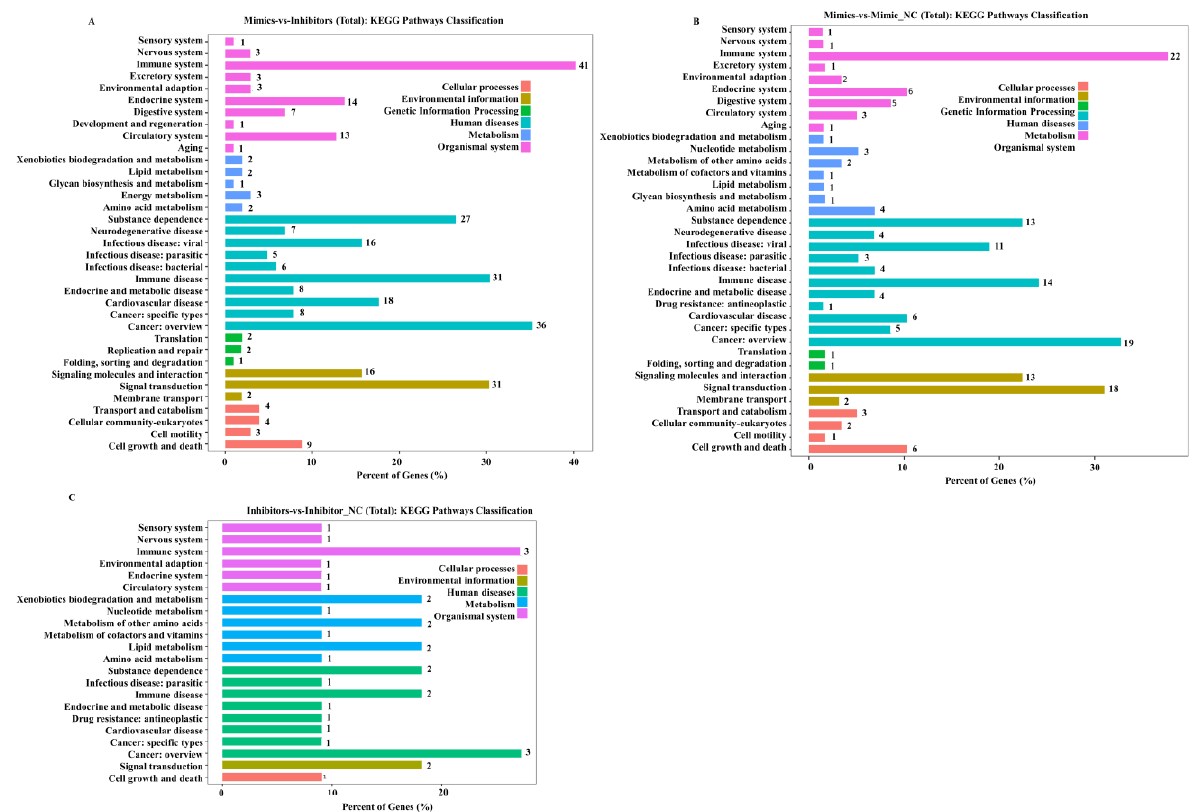
Figure 5. KEGG enrichment analyses of differentially expressed genes (DEGs) identified by RNA-seq in mouse NIH3T3 cells transfected with tRF-Trp-CCA-014 ( p < 0.05). ( A – C ) KEGG signalling pathways of Mimics vs. Inhibitors groups, Mimics vs. Mimic NC groups, and Inhibitors vs. Inhibitor NC groups, respectively. NC — negative control.